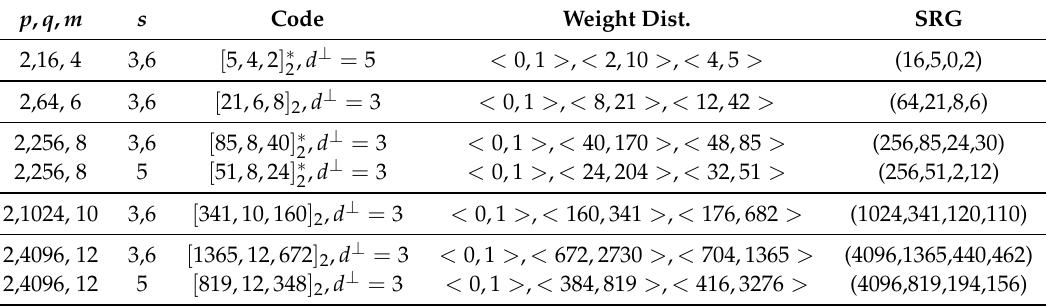
Table 6. Two-weight binary trace codes from nonzero powers of 3, 5 and